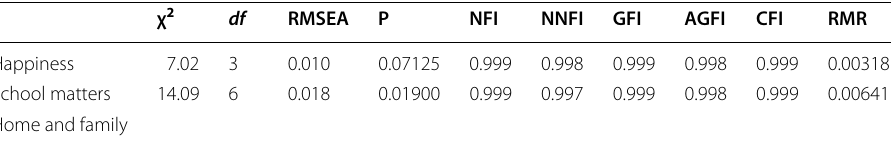
Table 3 Fit statistics of each of the constructs (CFA) χ